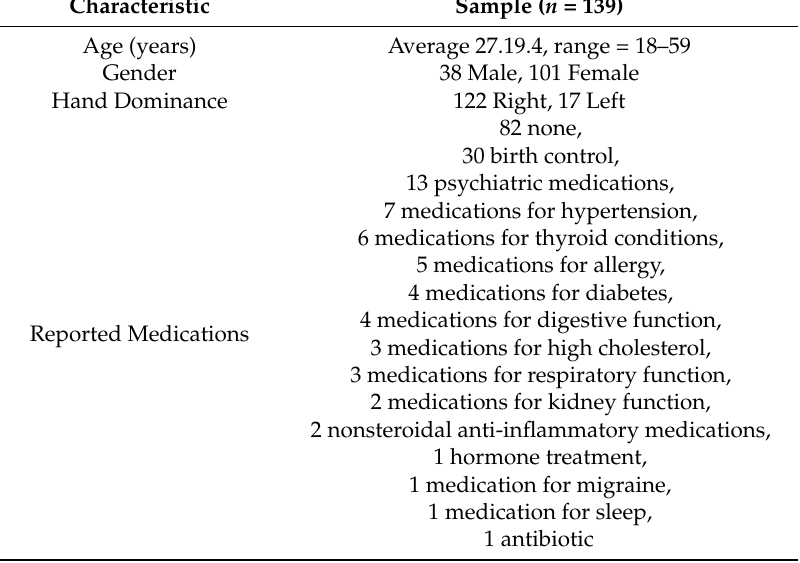
Table 1. Participant